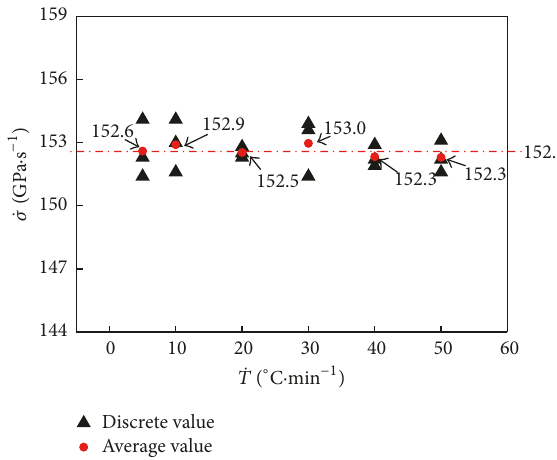
Figure 5: Tensile loading rates at different heating